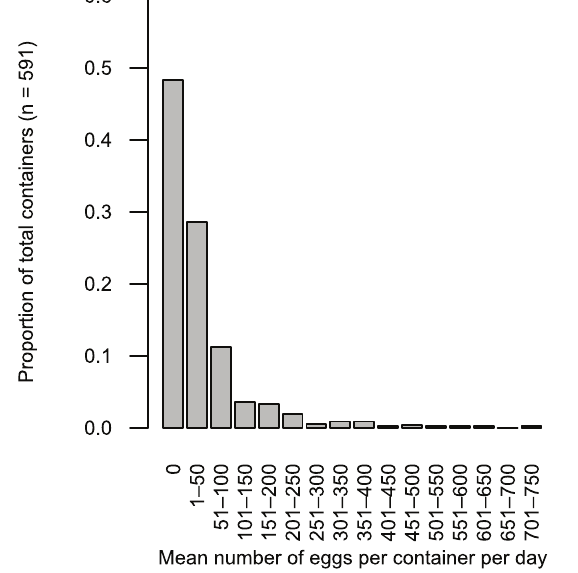
Figure 1. Frequency distribution of Ae.aegypti eggs. Number of eggs collected per day in naturally-occurring containers throughout Iquitos, Peru (n=591 containers).